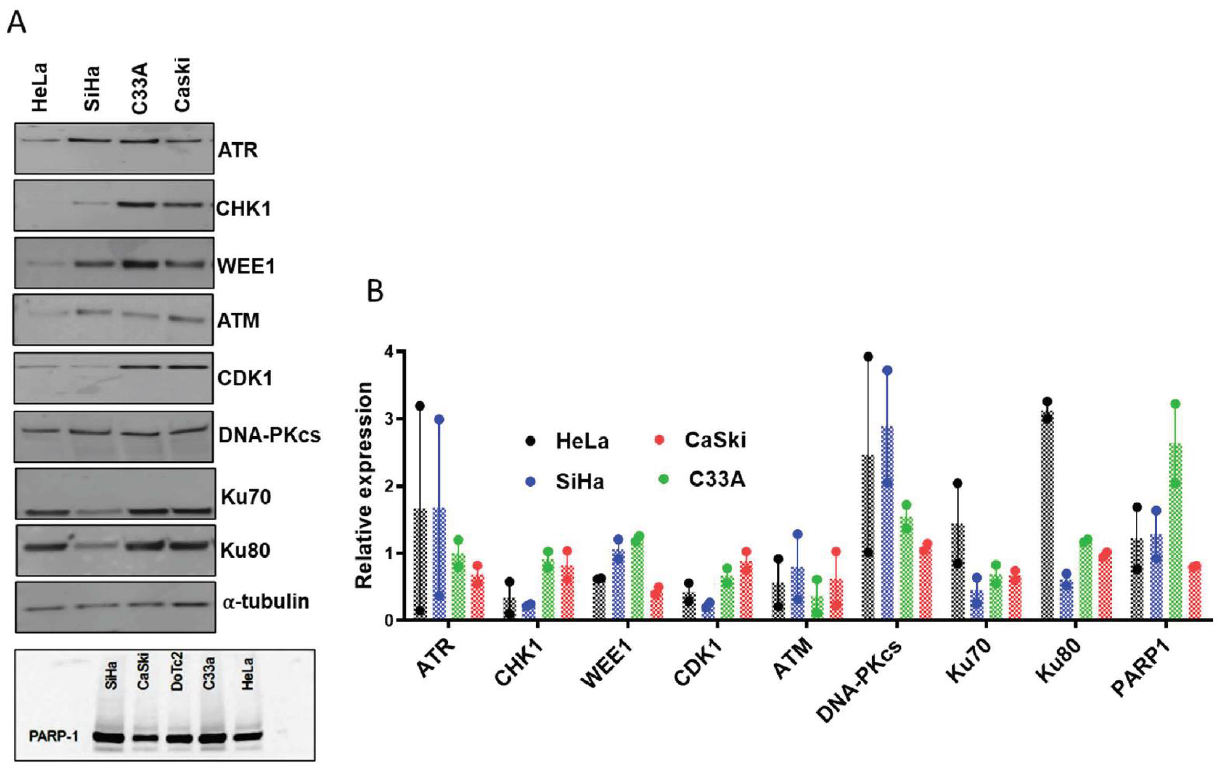
Figure 1. DDR protein expression in cervical cancer cell lines: ( A ) representative Western blots of key DDR proteins in cell lysates prepared from exponentially growing cells. ( B ) Densitometric